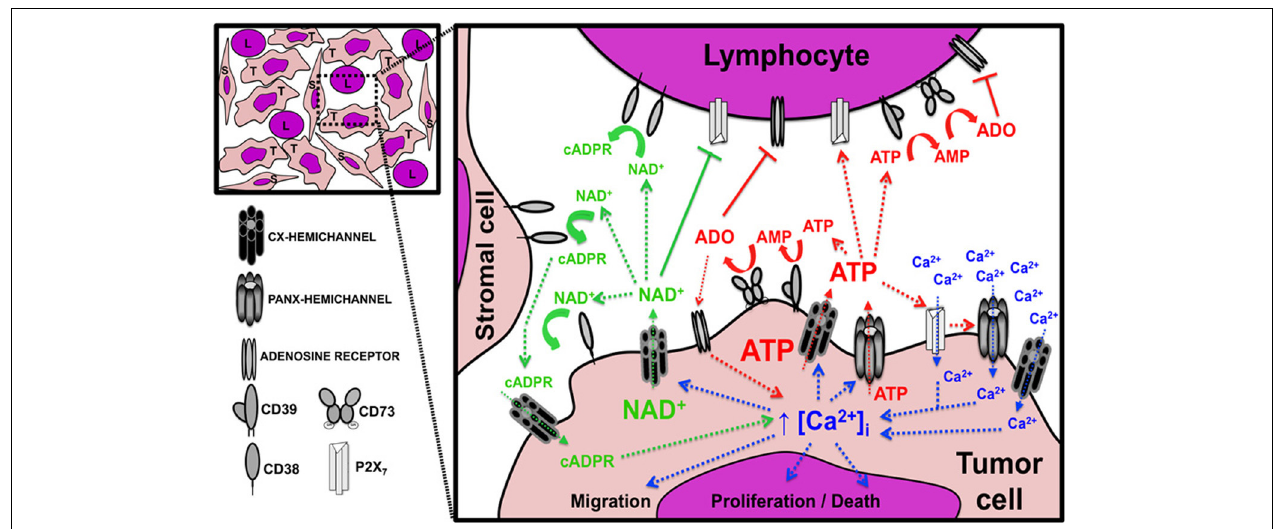
FIGURE 2 | Possible role of hemichannels in tumor growth and progression. Diagram showing the paracrine interactions mediated by the passage of nucleotides and Ca 2 + through hemichannels between tumor cells (T), lymphocytes (L), and stromal cells (S). The image in the upper left corner depicts the tumor microenvironment components with intimate relationship between the tumor and non-tumor cells. The expanded inset on the right represents a magnification of one tumor area and indicates the signaling circuits associated with NAD + (green text and arrows), ATP (red text and arrows), and Ca 2 + (blue text and arrows). The image also shows the